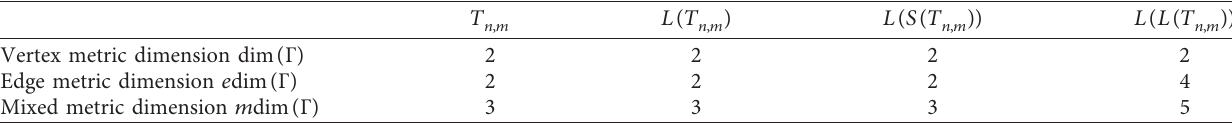
Table 7: Comparison of the metric dimension, edge metric dimension, and mixed metric dimension.